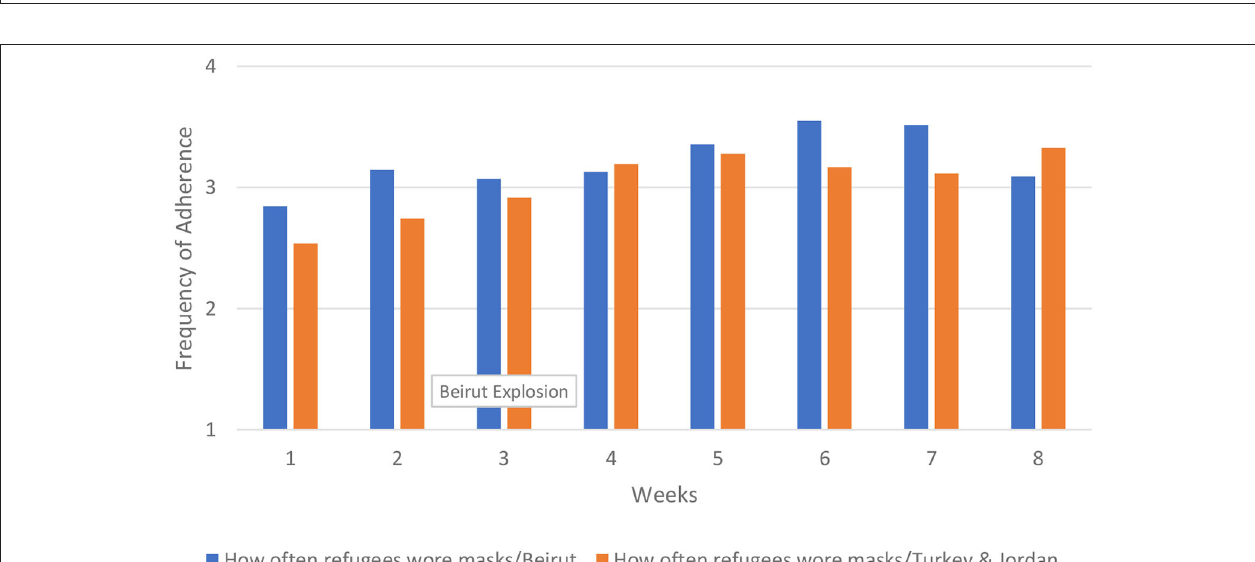
FIGURE 7 | How often staff maintained social distancing from refugees.